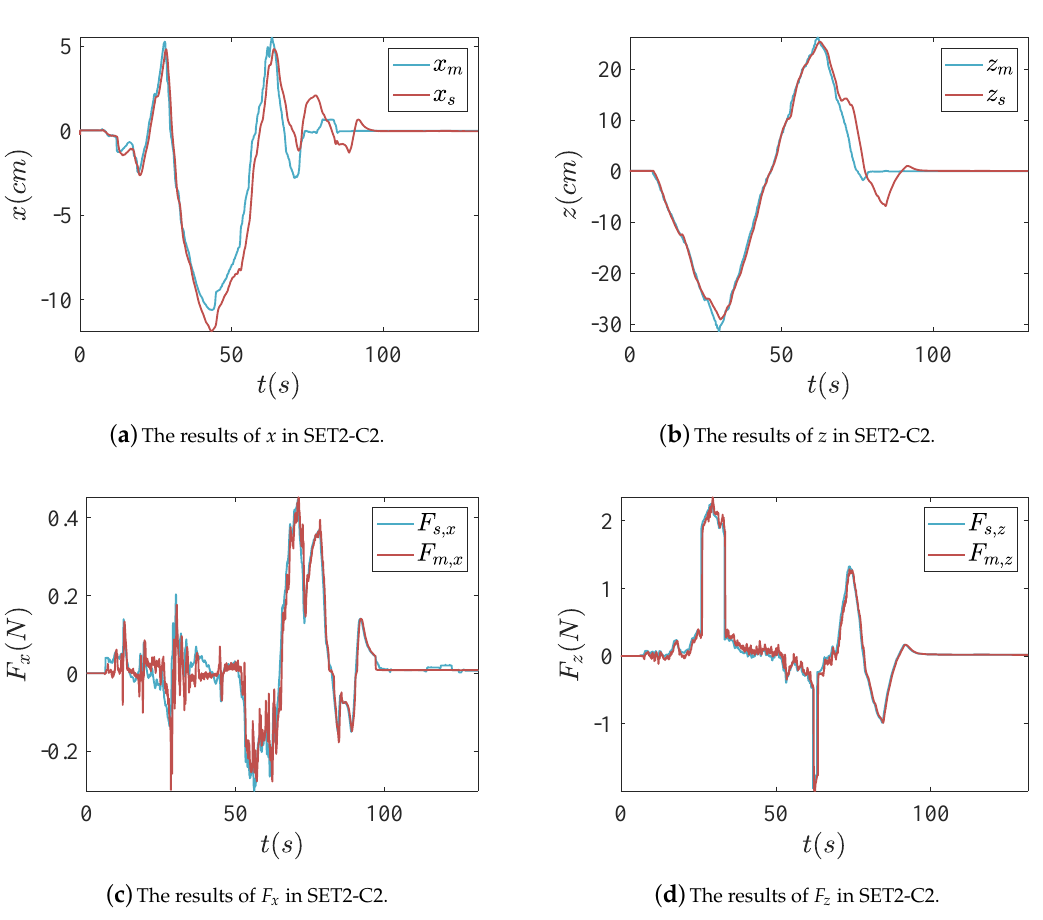
Figure 13. The results of